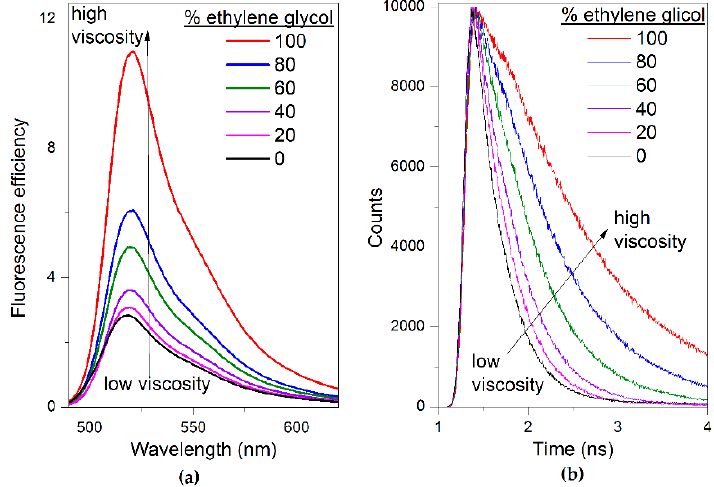
Figure 5. Evolution of the ( a ) fluorescence spectra (scaled by the fluorescence quantum yield) and ( b ) decay curves of dyad 6 with the content of ethylene glycol in diluted ethanolic solutions.